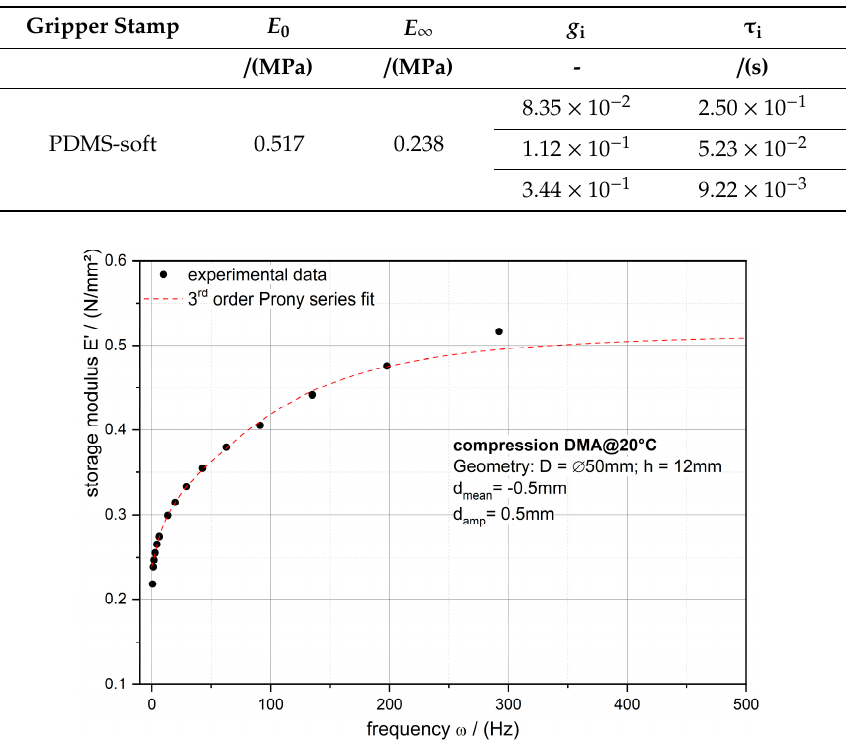
Figure 6. Linear plot of the frequency ( ω = 2 π )-dependent storage modulus E’ of PDMS-soft formulation (black points) with the 3rd order Prony series fit of the data (cf. Table 1) .